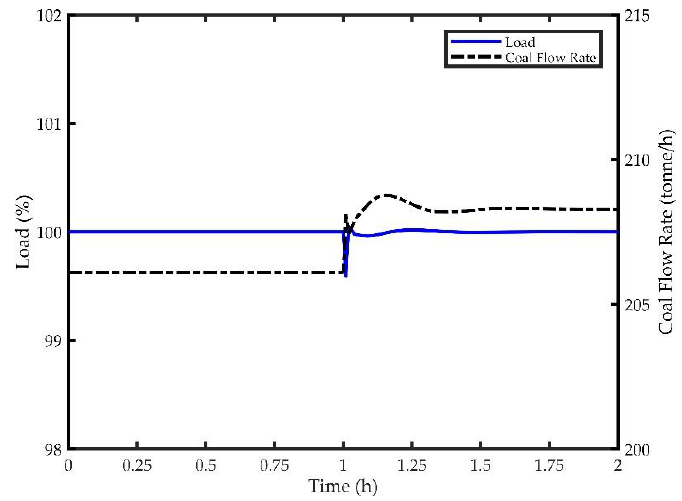
Figure 16. Disturbance Rejection Results for Load and Coal Flow.